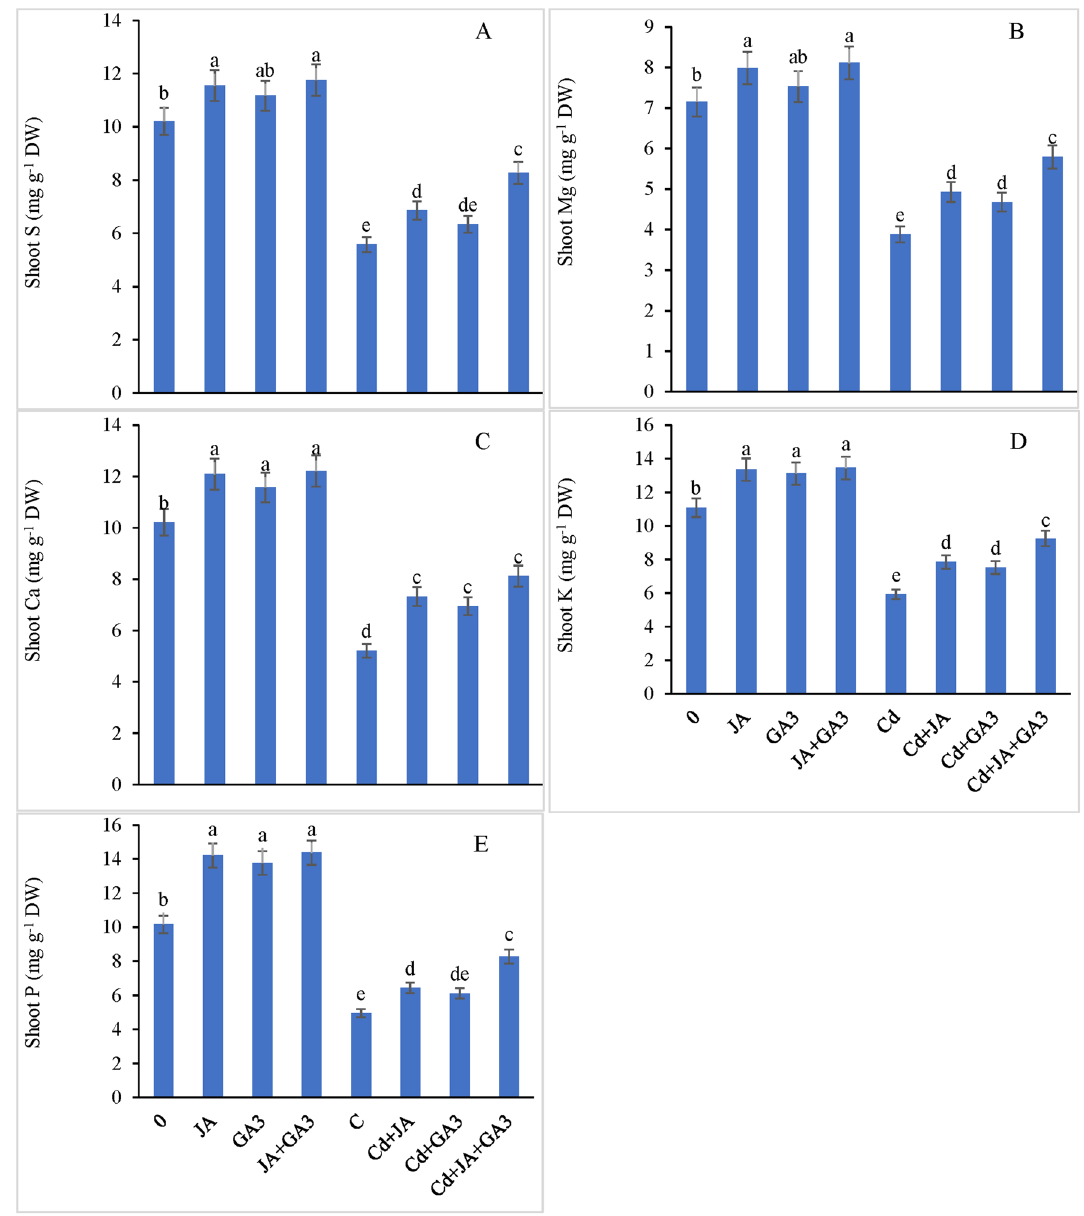
Figure 6. External supplementation of JA and GA 3 individually and/or in combination restored the shoot mineral elements; ( A ) sulfur (S), ( B ) magnesium (Mg), ( C ) calcium (Ca), ( D ) potassium (K), and ( E ) phosphorus (P) in Cd-stressed chickpea plants (Mean ±